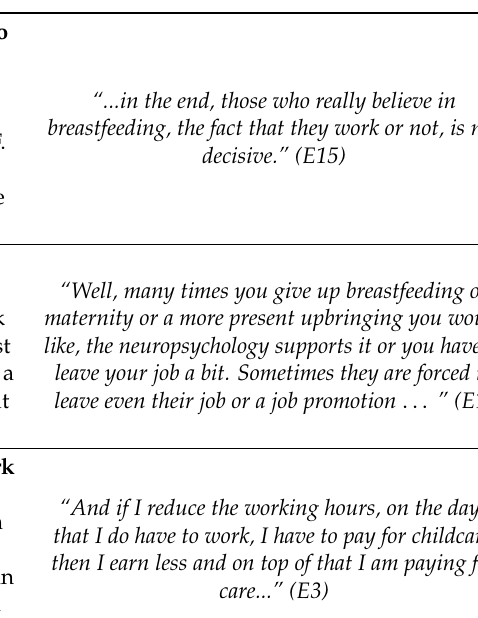
Table 5. Motivations and strategies to reconcile work and family